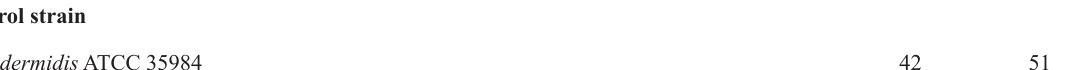
Each strain was individually evaluated and the values are expressed in percentage of inhibition of metabolic activity. Negative values indicate stimulation of cellular metabolic activity. A: Inhibition of metabolic activity on the initial cell adhesion; B: Inhibition of metabolic activity on the eradication of the preformed